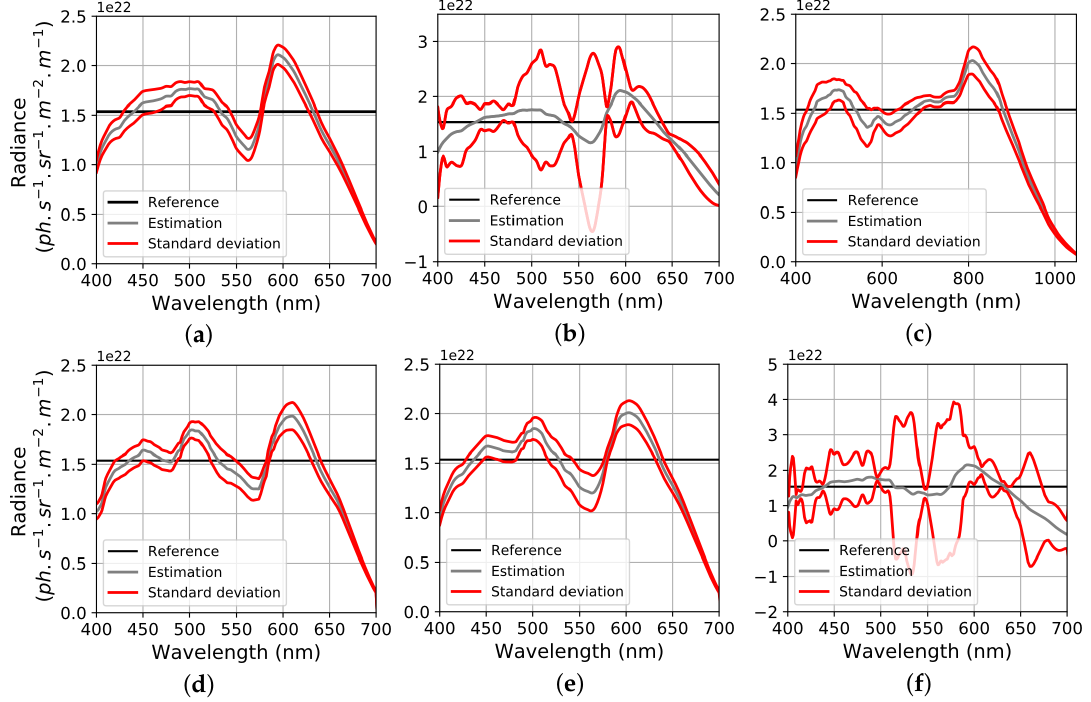
Figure 19. For each sensor, intrinsic spectral reconstruction with upper and lower standard deviations wavelength by wavelength (red curves are similar to standard deviation error bars). ( a ) RGB, ( b ) RGBW, ( c ) RGBWir, ( d ) CMY, ( e ) RYB, ( f ) RGBC.